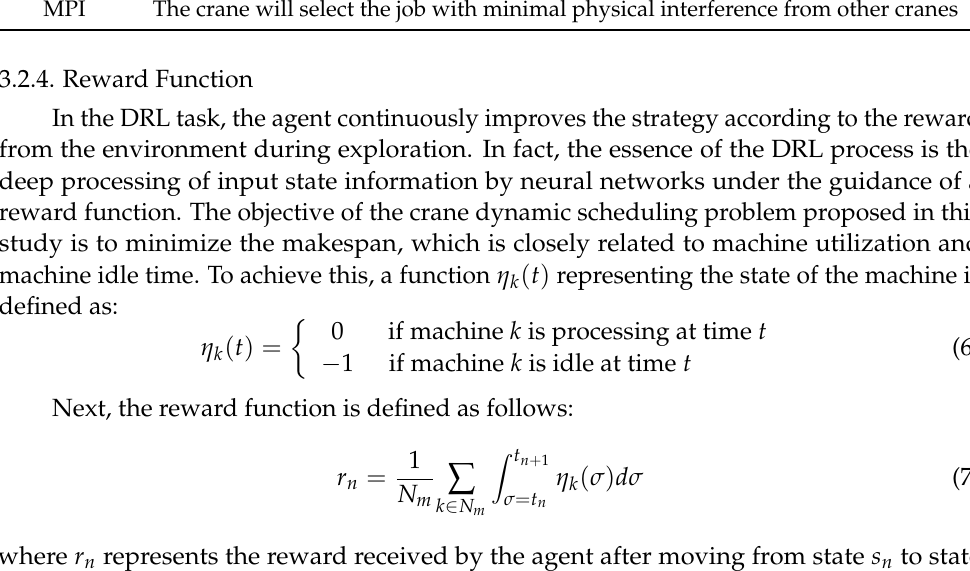
Table 1. Heuristic rules for job selection. Rule Description FIFO Select the job with the first coming SPT Select the job with the shortest processing time STD Select the job with the shortest transportation distance SRPT Select the job with the shortest remaining processing time NVF The crane will select the job with the nearest load machine (Euclidean distance) LWT Select the job with the longest waiting time FRO Select the job with the fewest remaining operations MPI The crane will select the job with minimal physical interference from other